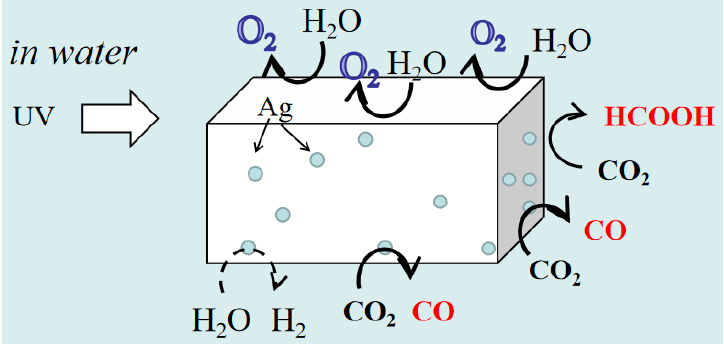
Figure 4. Mechanism of photocatalytic reduction of CO 2 by Ag-loaded BaLa 4 Ti 4 O 15 [80].